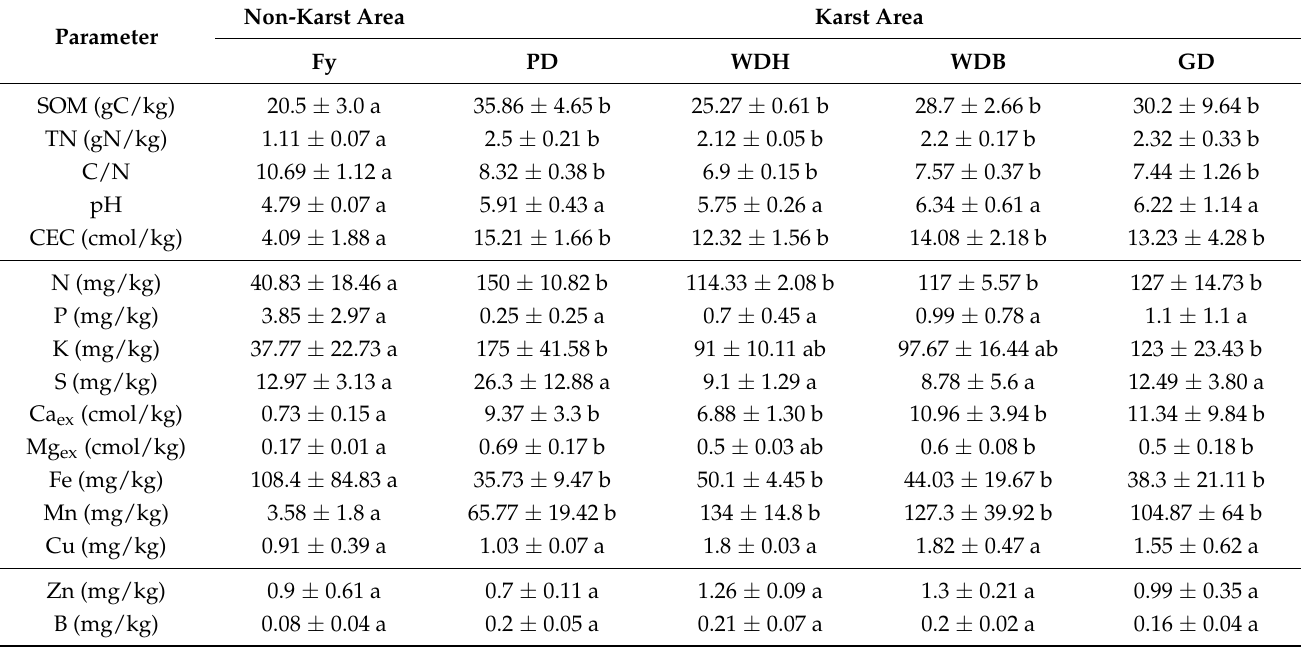
Table 2. The topsoil physical and chemical properties of the different landforms in the karst areas and non-karst